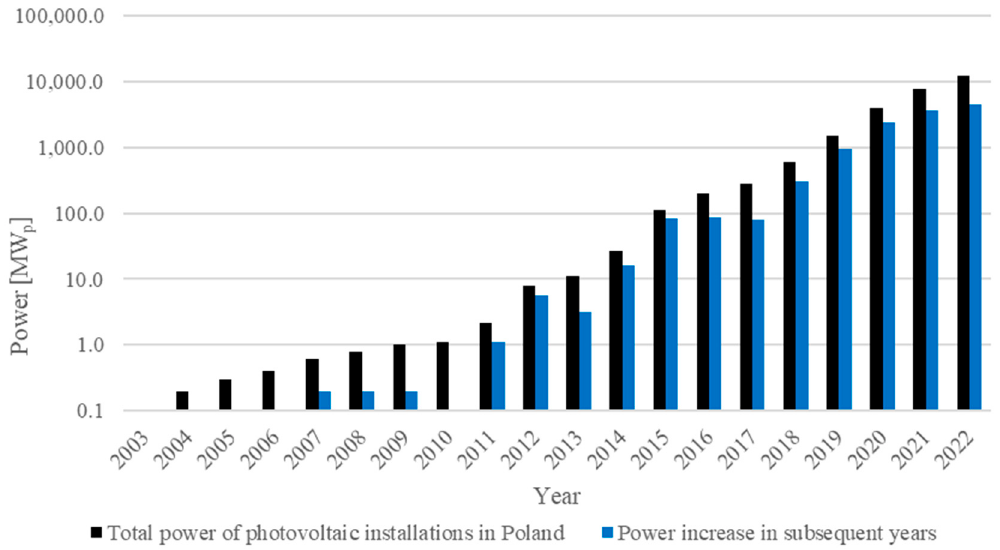
Figure 6. Development of photovoltaic market in Poland with regard to changes of installed capacity in the last 20 years.